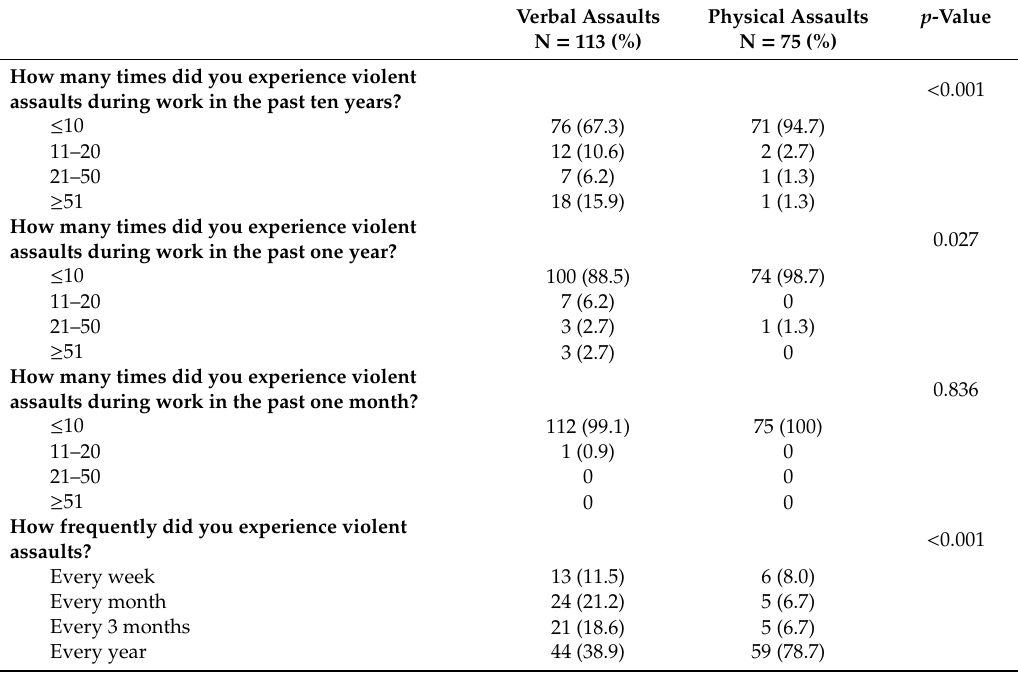
Table 2. Frequency of workplace